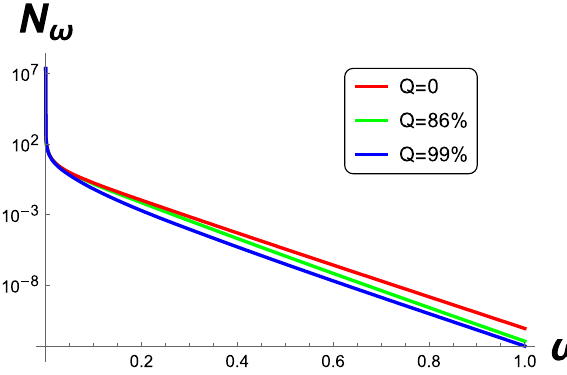
Fig. 3 The particle spectrum, Eq. (18), in a semi-log plot, demon- strating less particles emitted as the charge is increased. An infrared divergence, for ω → 0 is present, which signals the usual infinite total particle count due to the soft particles at ω = 0. The plot includes the Schwarzschild spectrum, Q = 0, Eq. (19). Here we set M =